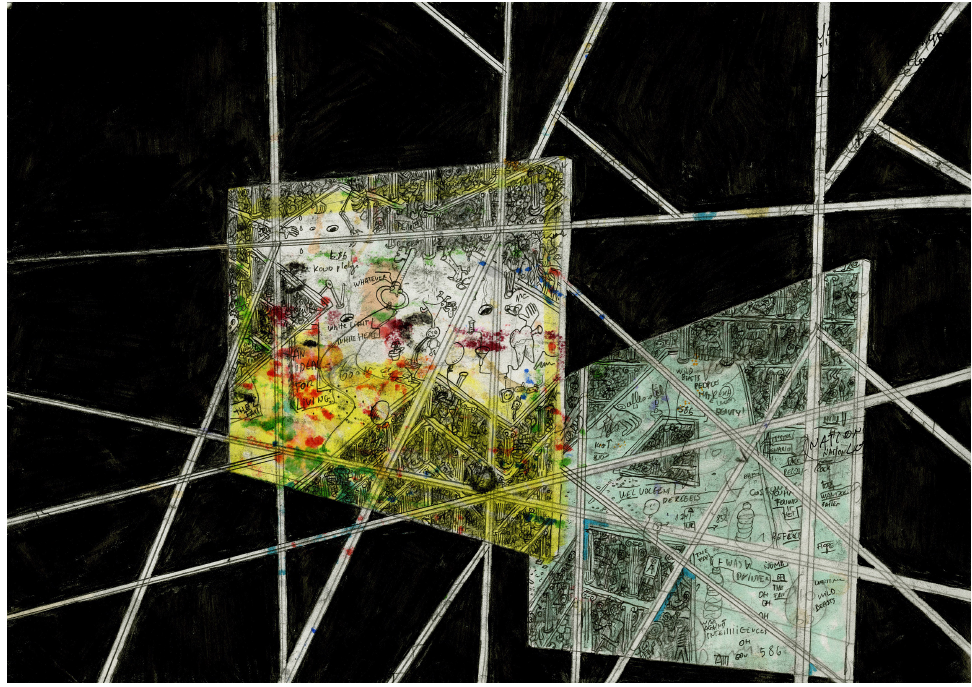
Figure 3: Andy is still wondering if a happy thought is a pure rational